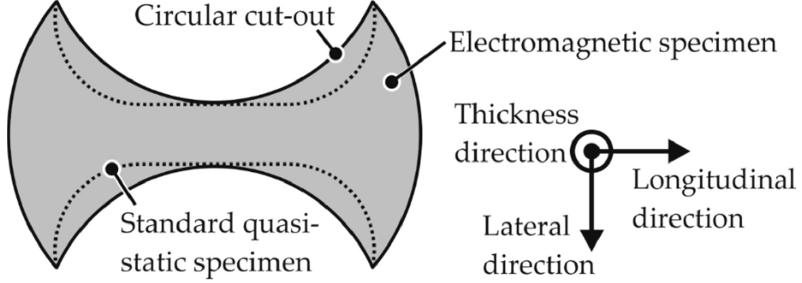
Figure 6. The electromagnetic forming limit test replaces the standard doge-bone shape with circular cutouts in the deforming region of the specimens.